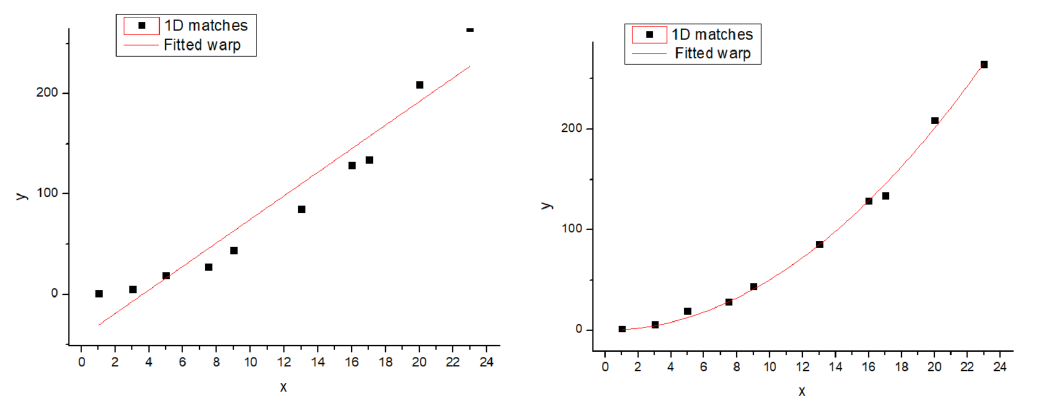
Figure 2. To generate a 1D analogy of image stitching, a set of 1D matches { x n , y n } N by projecting a 2D point cloud onto two 1D image “planes”. Here, the two views differ by a rotation and translation. The first indicates that the match points are warped by a global homography and it is unable to model the local deviations of the data. The second indicates that the match points are warped by some local homography and it interpolates the local deviations